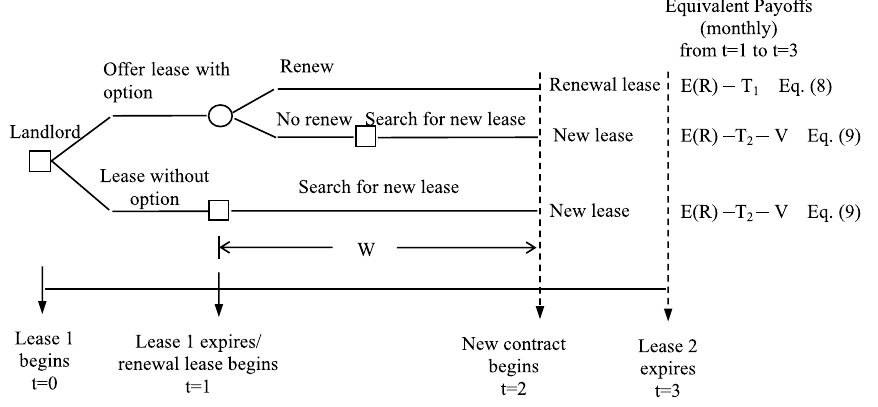
Fig. 1 Decision tree and landlord